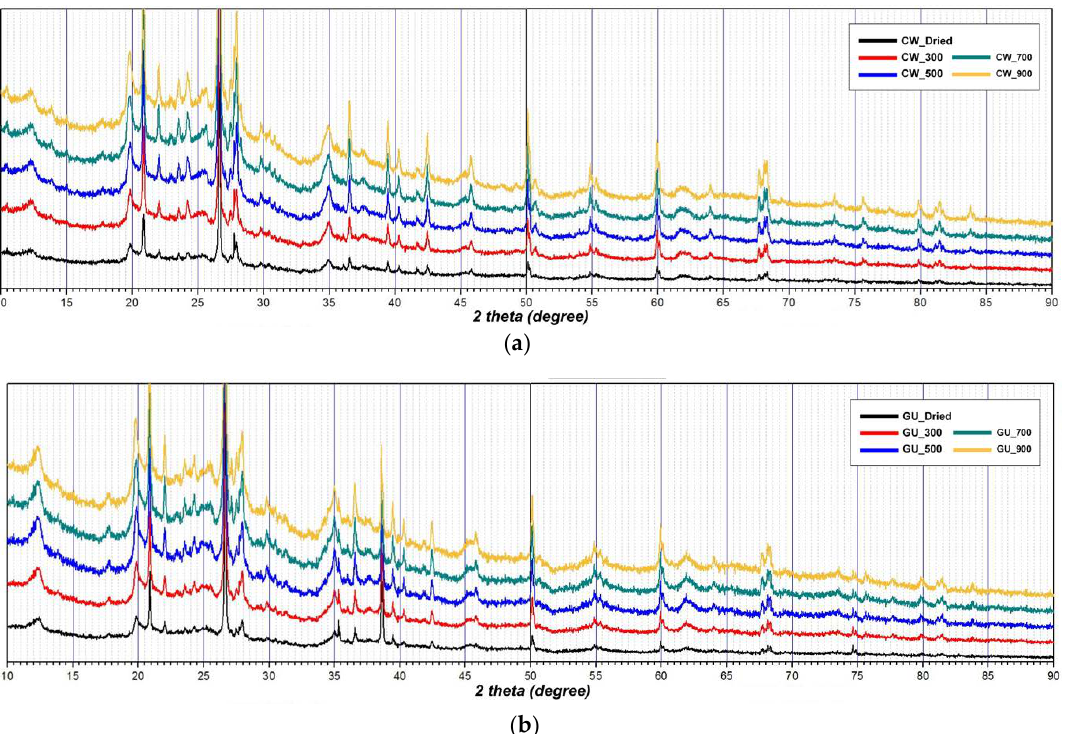
Figure 3. X-ray diffraction (XRD) results of water treatment sludge and pyrolyzed char for ( a ) CW and ( b ) GU.